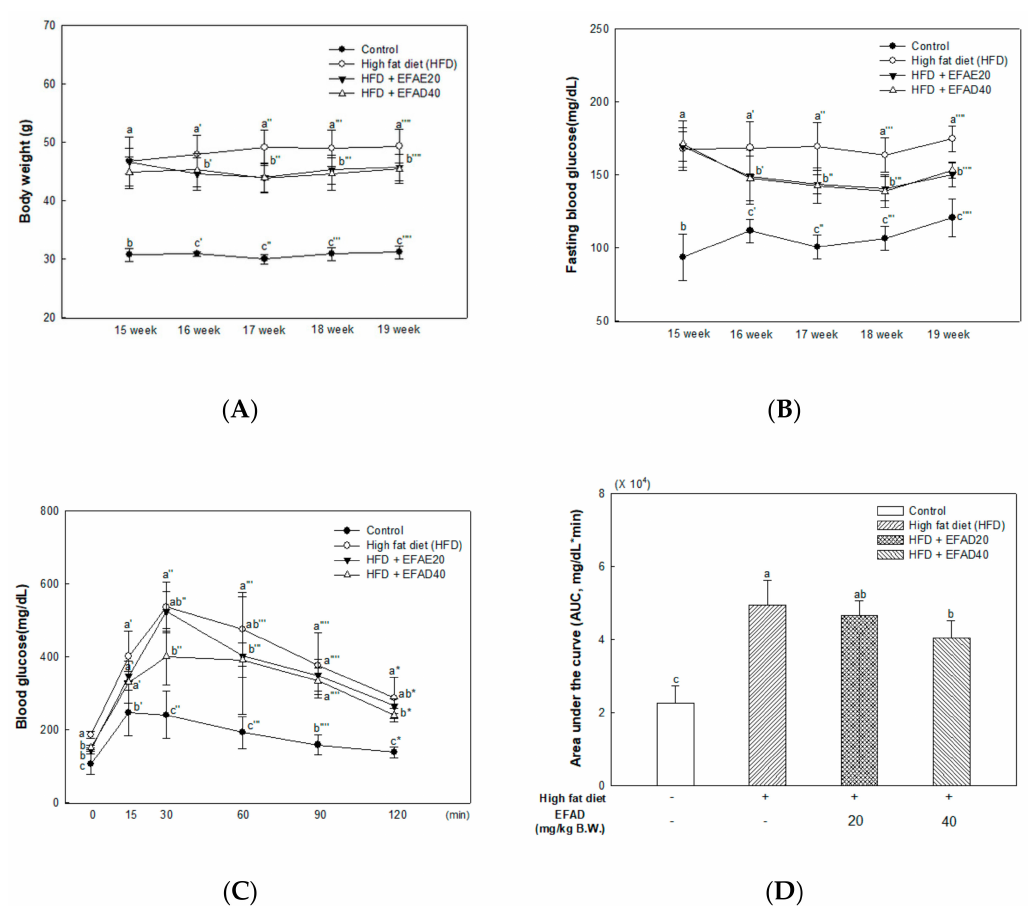
Figure 2. E ff ect of ethyl acetate fraction from Aruncus dioicus var. kamtschaticus (EFAD) on obesity and impaired glucose tolerance induced by high-fat diet (HFD). ( A ) Average of body weight. ( B ) Fasting blood glucose from 15 week to 19 week. ( C ) Intraperitoneal glucose tolerance (IPGTT) test. ( D ) Area under the curve (AUC) in IPGTT. The values shown are as mean ± SD ( n = 7). The data were statistically considered at p < 0.05 and they were represented as di ff erent small